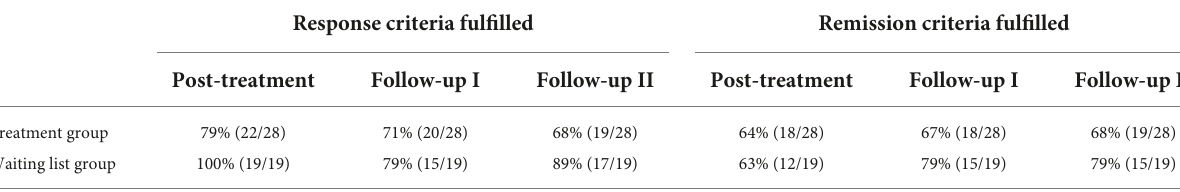
TABLE 4 Response and remission rates for participants who completed treatment.